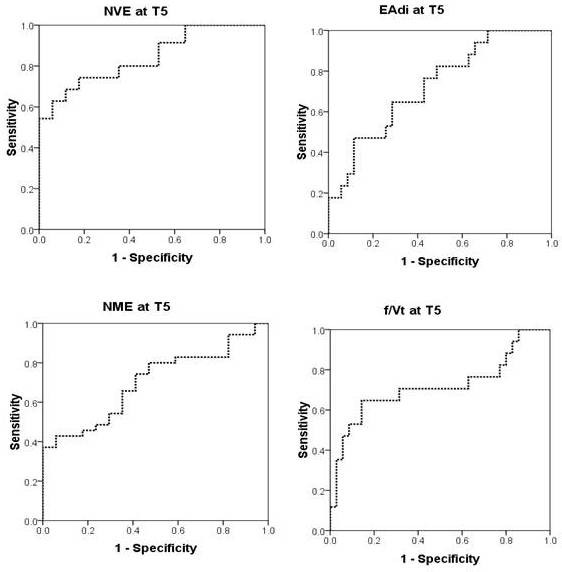
Upper left panel shows the ROC curve (receiver operating characteristic) for neuroventilatory efficiency (NVE) to predict extubation success after 5 minutes of the spontaneous breathing trial (T5). Area under the curve (AUC) was 0.84 (P < 0.001). Upper right panel shows the ROC curve for diaphragm electrical activity (EAdi) to predict extubation failure at T5. AUC was 0.73 (P < 0.009). Lower left panel shows ROC curve for neuromuscular efficiency (NME) to predict extubation success at T5. AUC = 0.70 (P < 0.02).The lower right panel shows the ROC curve for the ratio of breathing frequency and tidal volume (f/Vt) to predict extubation failure at T5. AUC was 0.72 (P = 0.012).